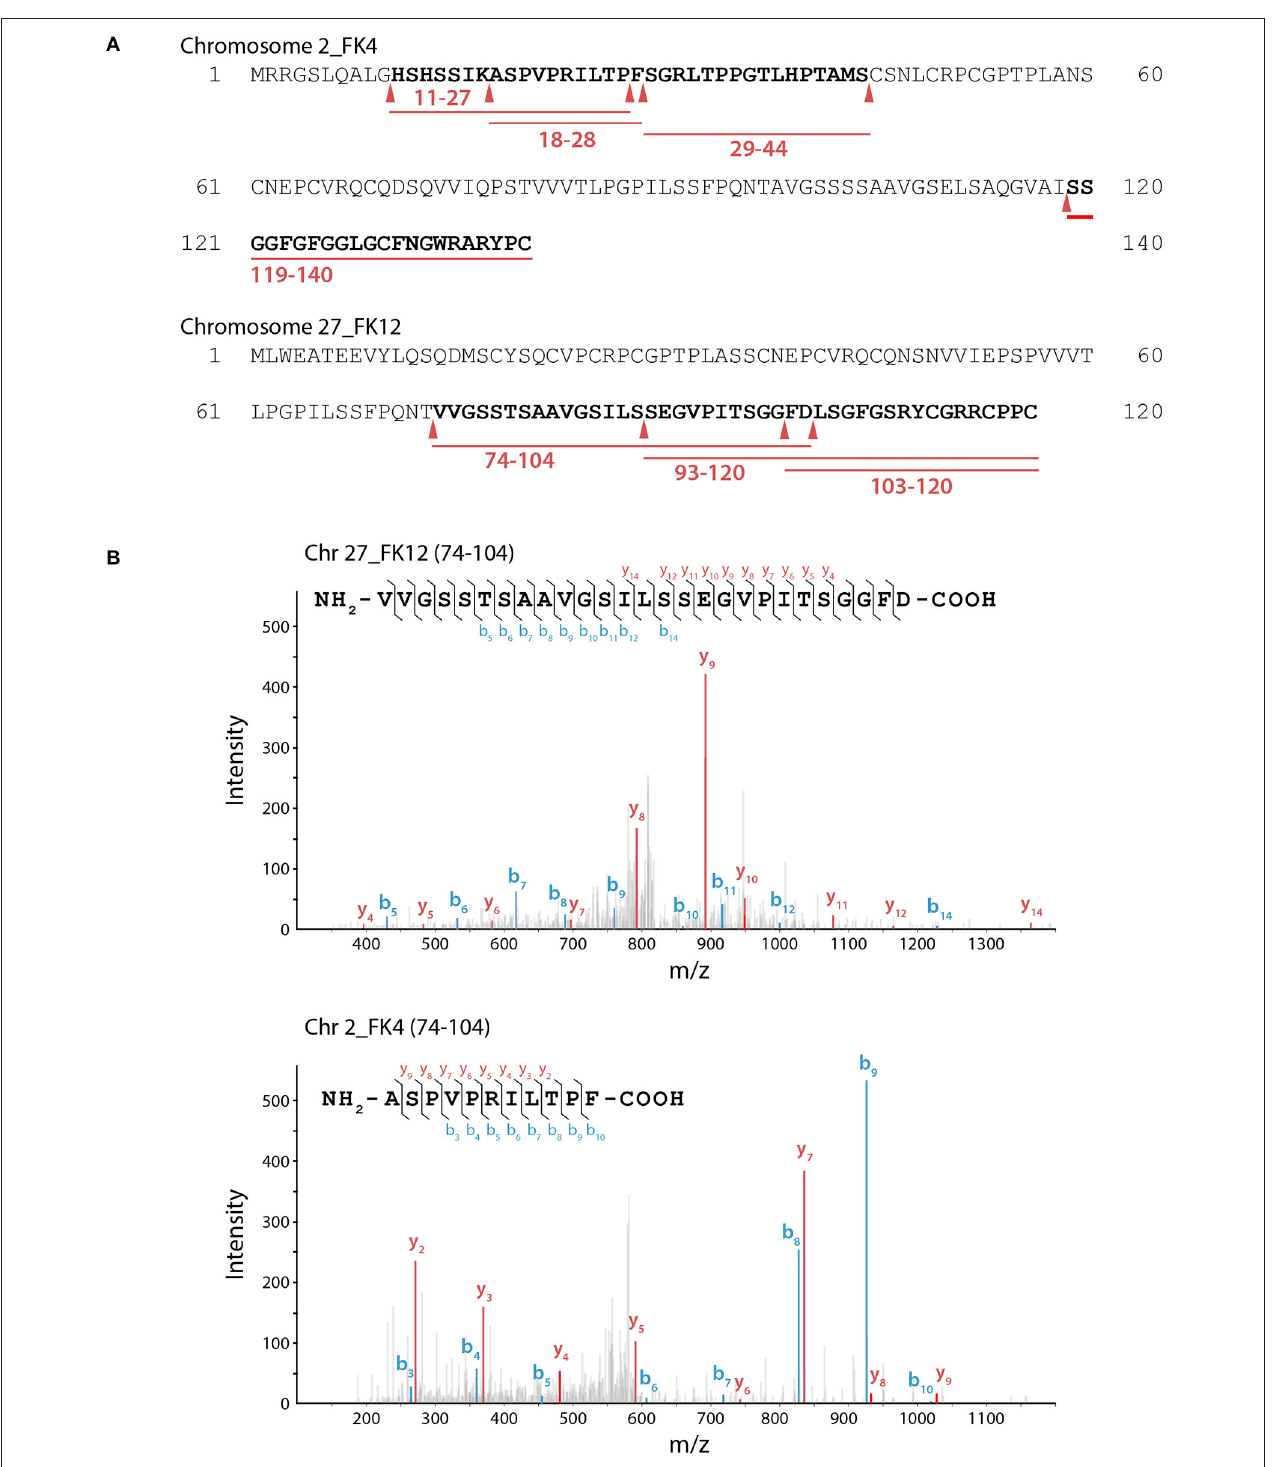
FIGURE 3 | LC-MS/MS analysis of keratin hydrolysates generated by Fi BAP. (A) Keratinolytic peptides matched with soluble Chr2_FK4 and Chr27_FK12 β -keratins are underlined in red, and their coverage sequences are depicted in bold. Red arrows indicate the putative cleavage site of Fi BAP from the identified peptide sequences. Purified recombinant feather keratin and Fi BAP were incubated for 18h at 80 ◦ C in 50mM Tris-HCl (pH 7.5). The enzyme/substrate ratio was 1:50 (w/w). (B) Representative MS spectra of keratinolytic peptides and fragment ions of detected peptides from recombinant feather keratins. The identified fragment ions from peptide sequences are labeled in the spectra and indicated on the peptide sequence above. The b (blue) and y (red) peaks correspond to the majority of the N- and C- terminal ions resulting from fragmentation of each peptide, respectively.